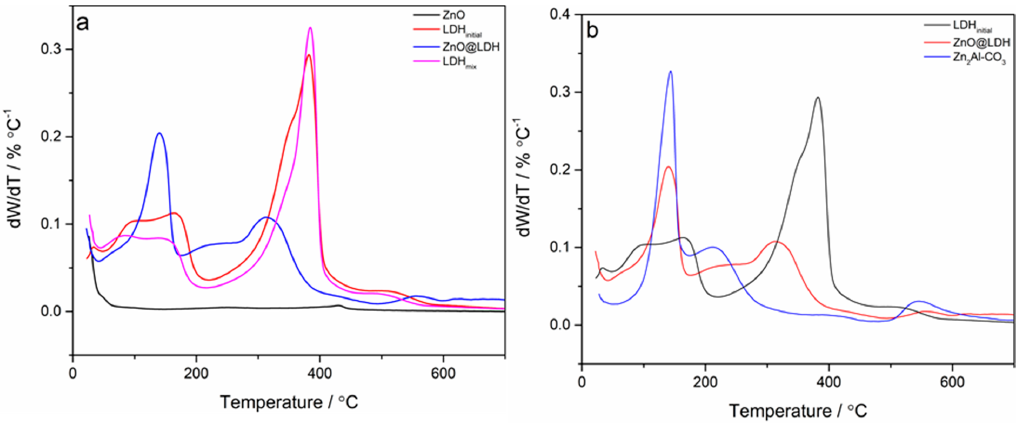
Figure 5. Derivative thermal decomposition of ( a ) ZnO, LDH initial , LDH mix , and ZnO-LDH ( b ) Zn 2 Al-CO 3 ZnO-LDH and LDH initial . All samples heated to 700 °C with a rate of 5 °C min − 1 40 mL min − 1 flow rate of N 2 .